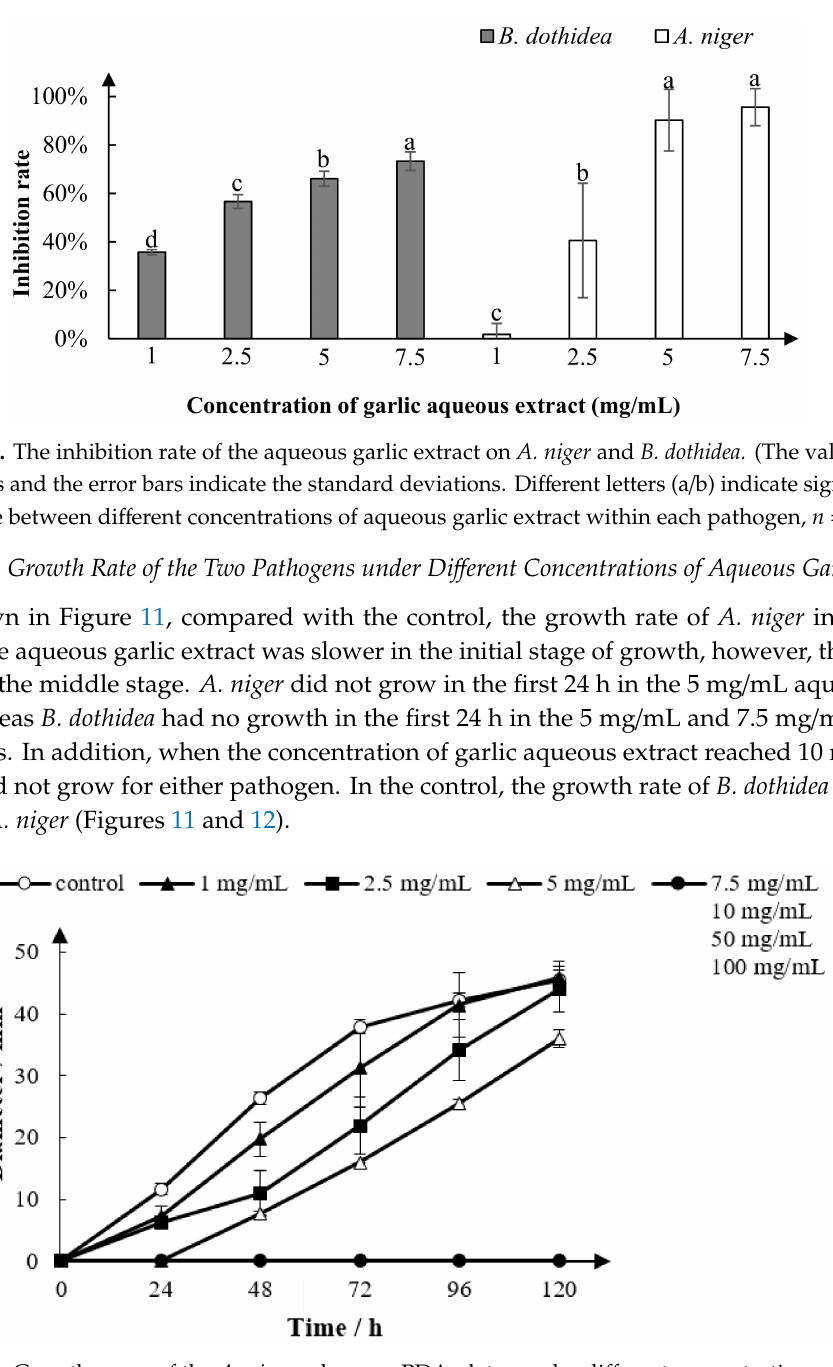
Figure 11. Growth curve of the A. niger colony on PDA plates under di ff erent concentrations of garlic extract ( n =